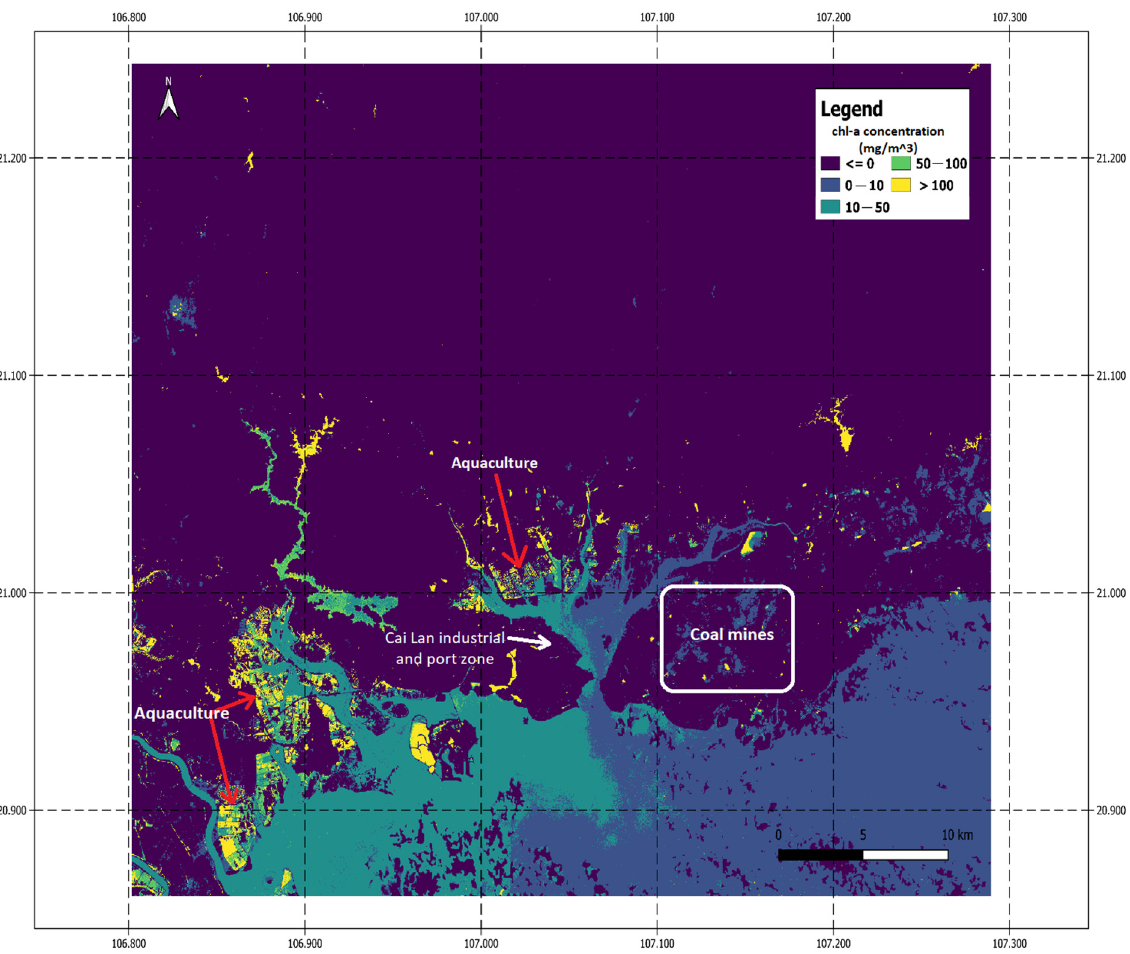
Figure 6. Map of the mean chlorophyll-a concentration from 2019 to 2021.